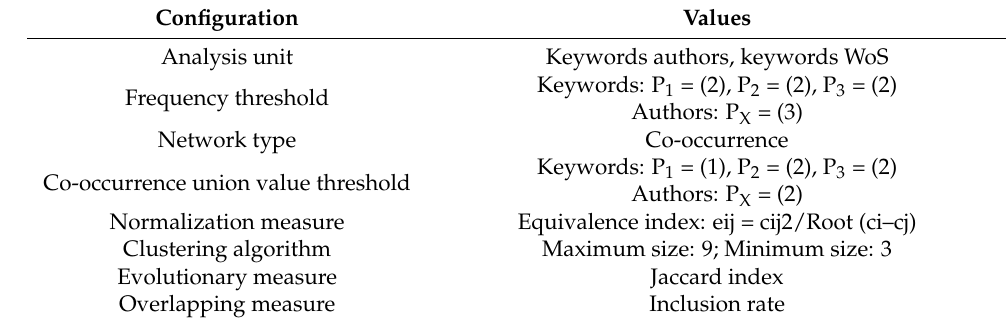
Table 1. Production indicators and inclusion